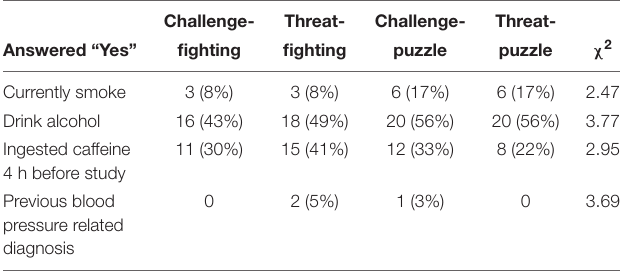
TABLE 2 | Frequencies and percentages for group comparisons across health indicators.